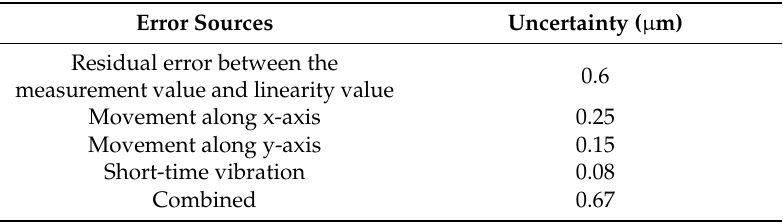
Table 1. Measurement uncertainty of differential capacitive